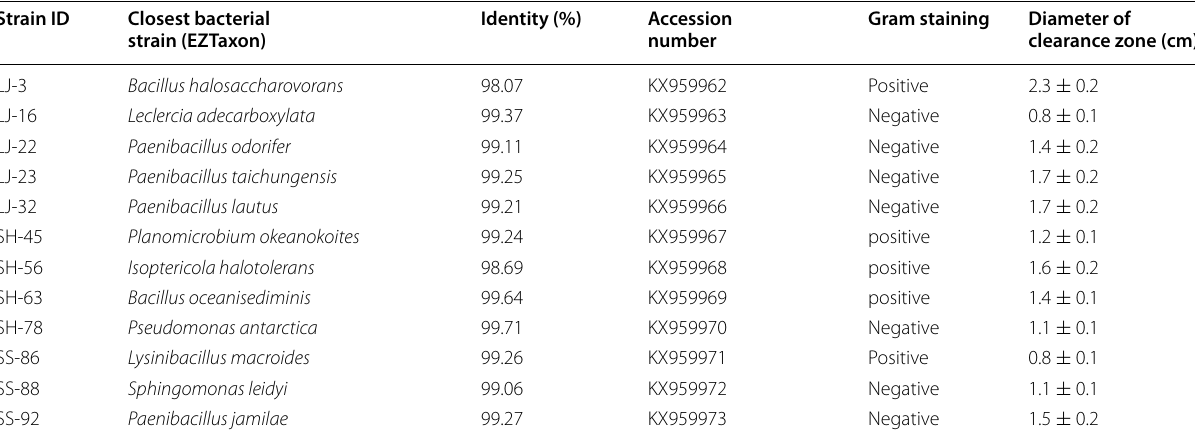
Table 1 Identified isolates, each with the closest type strain, the 16S rRNA gene similarity and the observed enzyme